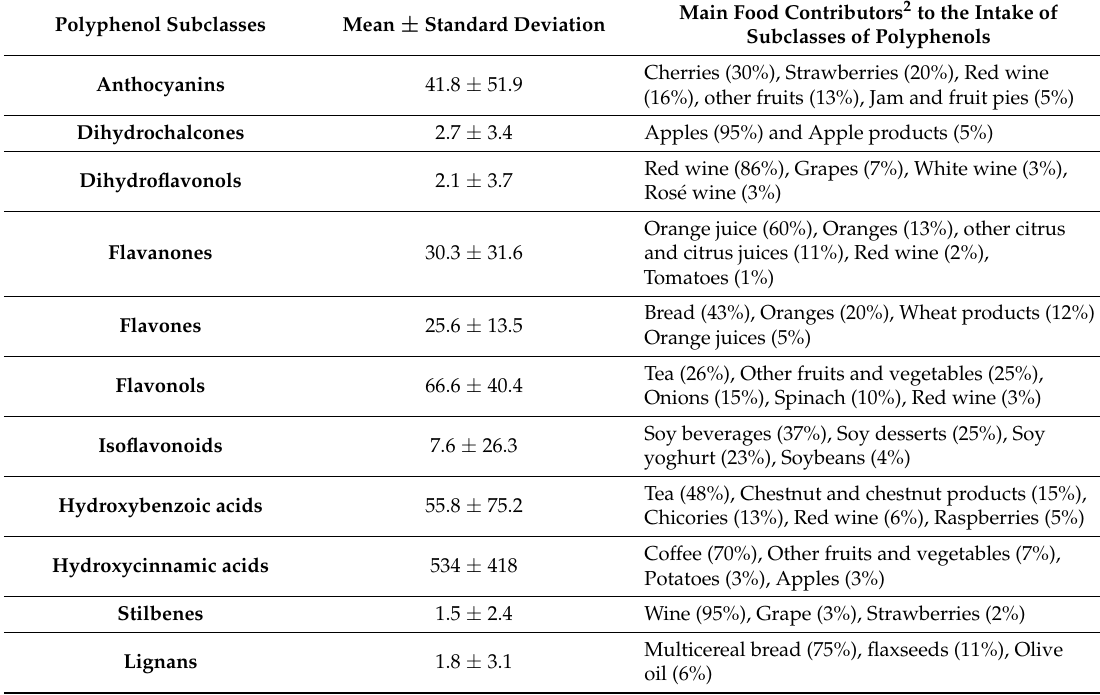
Table 1. Contributions 1 of different food groups to the intake of polyphenol subclasses in the 84,158 participants of the Nutrinet Sant é